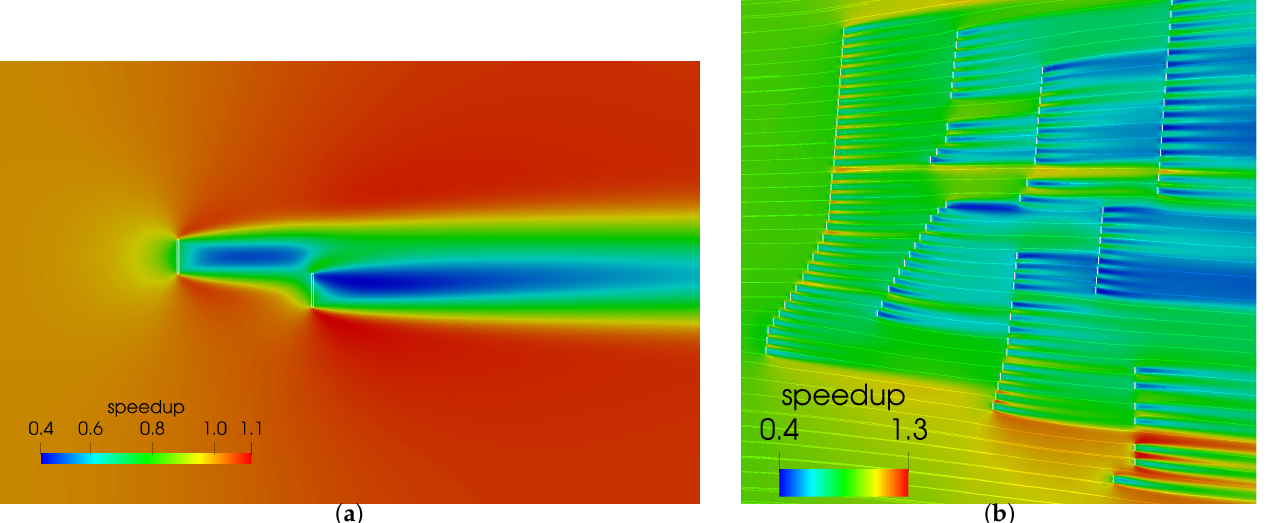
Figure 1. Wind speedup of the model for ( a ) a two turbine configuration and ( b ) the Sisante wind farm (115 turbines), illustrating in white the actuator disc